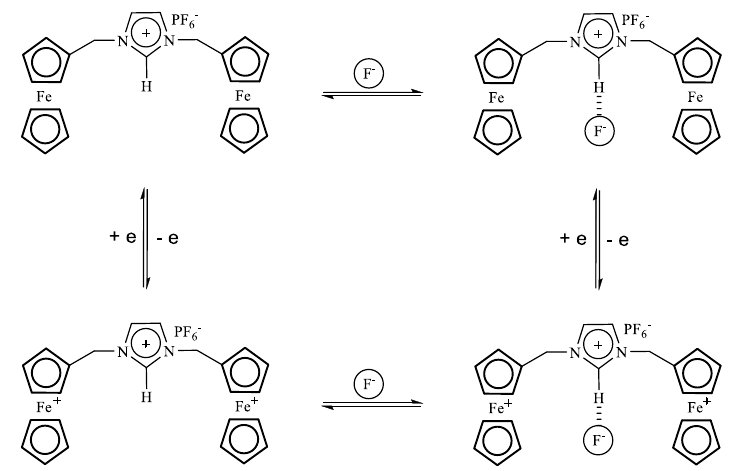
Figure 5. Anion-binding-induced potential shift as a function of the reciprocal of the radius of the halide ion in ligand 2 .